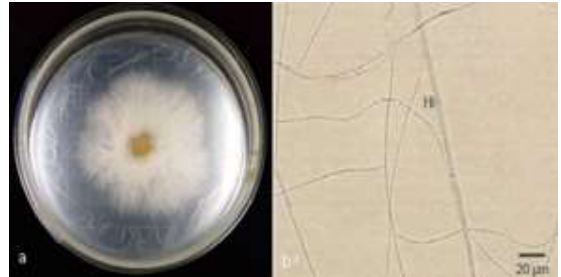
Figure 1. a. Endophytic fungus isolated from leaves of C.amboinicus on PDA plate at 5 days of incubation. b. Hyaline form on microscopic observation.